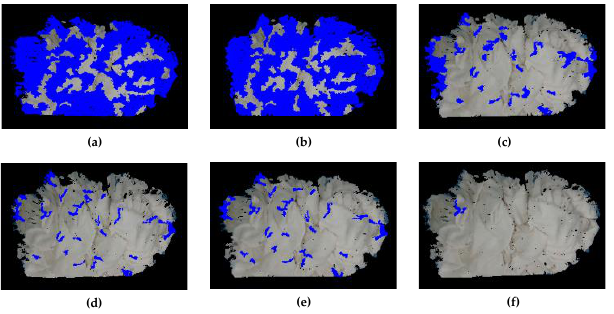
Figure 6. The segmented convex wrinkles with different k : ( a ) k = 0.5; ( b ) k = 0.9; ( c ) k = 0.99; ( d ) k = 1; ( e ) k = 3; ( f ) k = 1000.